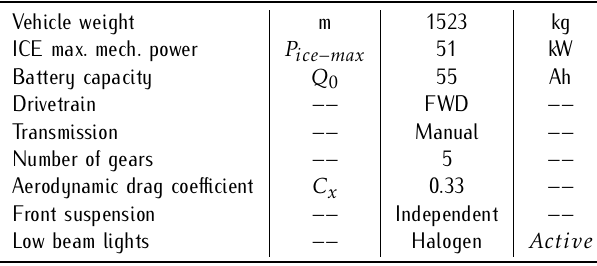
Table 1. Vehicle Parameters